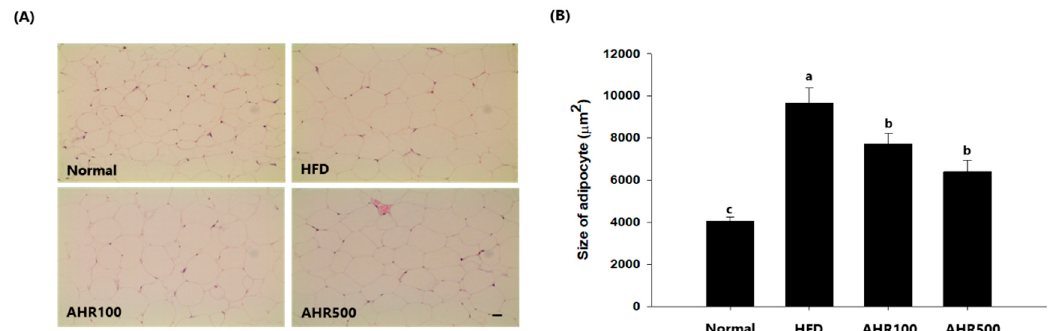
Figure 3. Effects of AHR on fat tissue morphology ( A ) and fat size ( B ) in HFD-induced obese mice. Hematoxylin–eosin staining of epididymal adipose tissue sections from respective mice of each group (scale bar = 100 µm). Original magnification 200×. Data are expressed as mean ± SEM ( n = 6–8). Values with different letters are significantly different at p < 0.05.